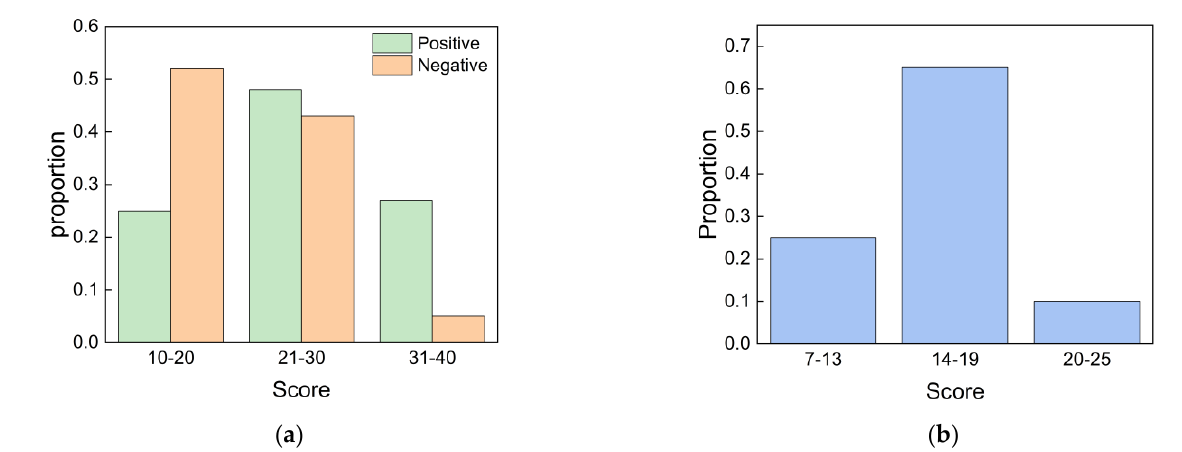
Figure 11. Subjective evaluation of well-being: ( a ) PANAS score; ( b ) WHO-5 well-being index score.